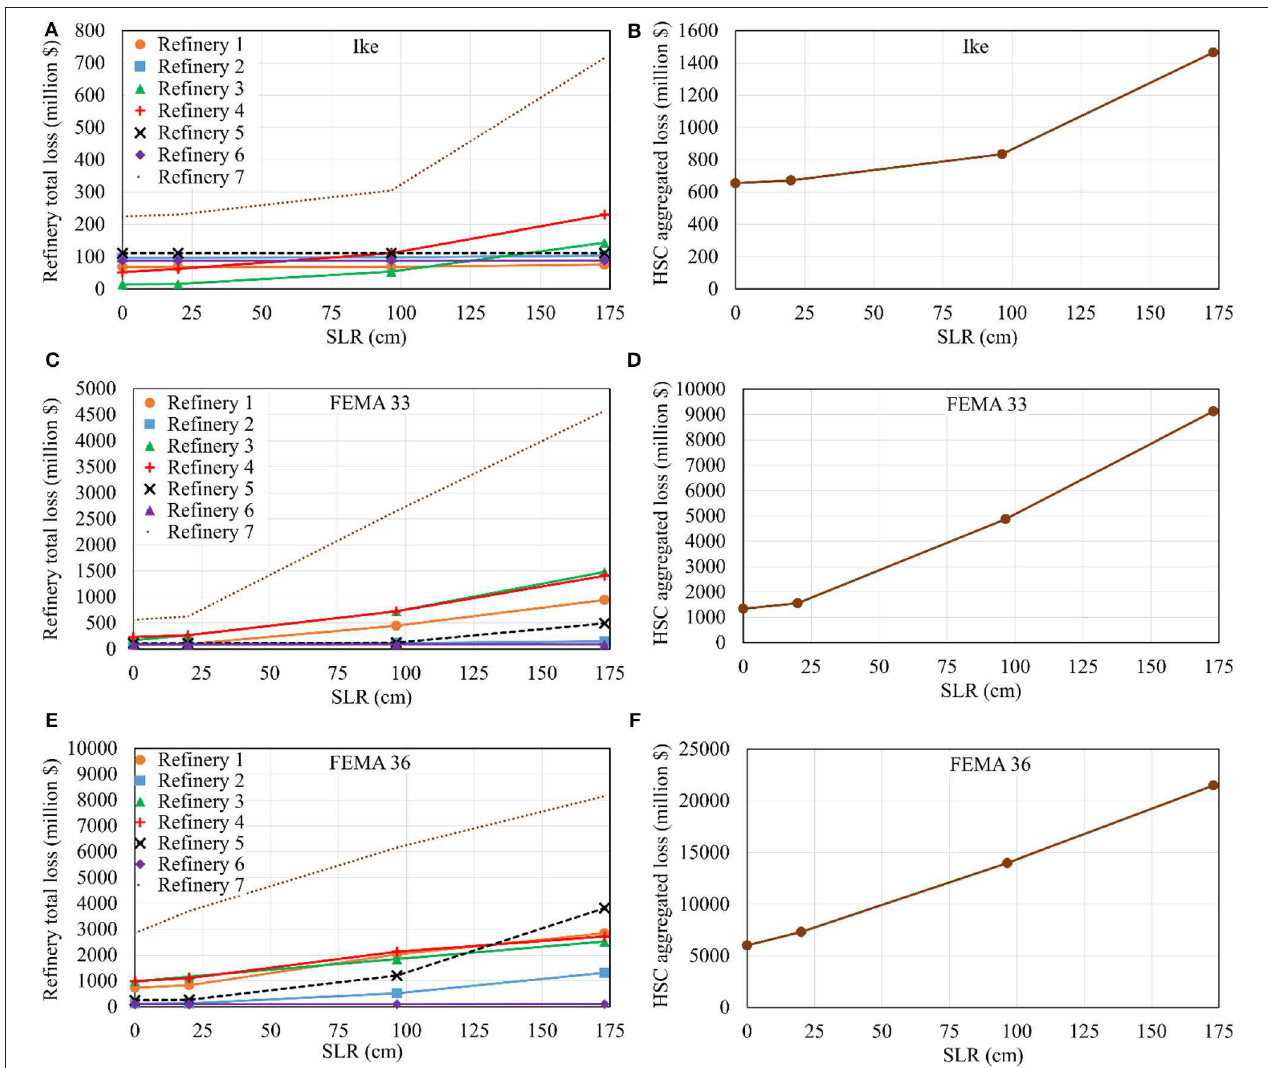
FIGURE 12 | Effect of SLR on the refinery total losses and the HSC aggregated loss caused by Hurricane Ike, FEMA 33, and FEMA 36 with their original forward